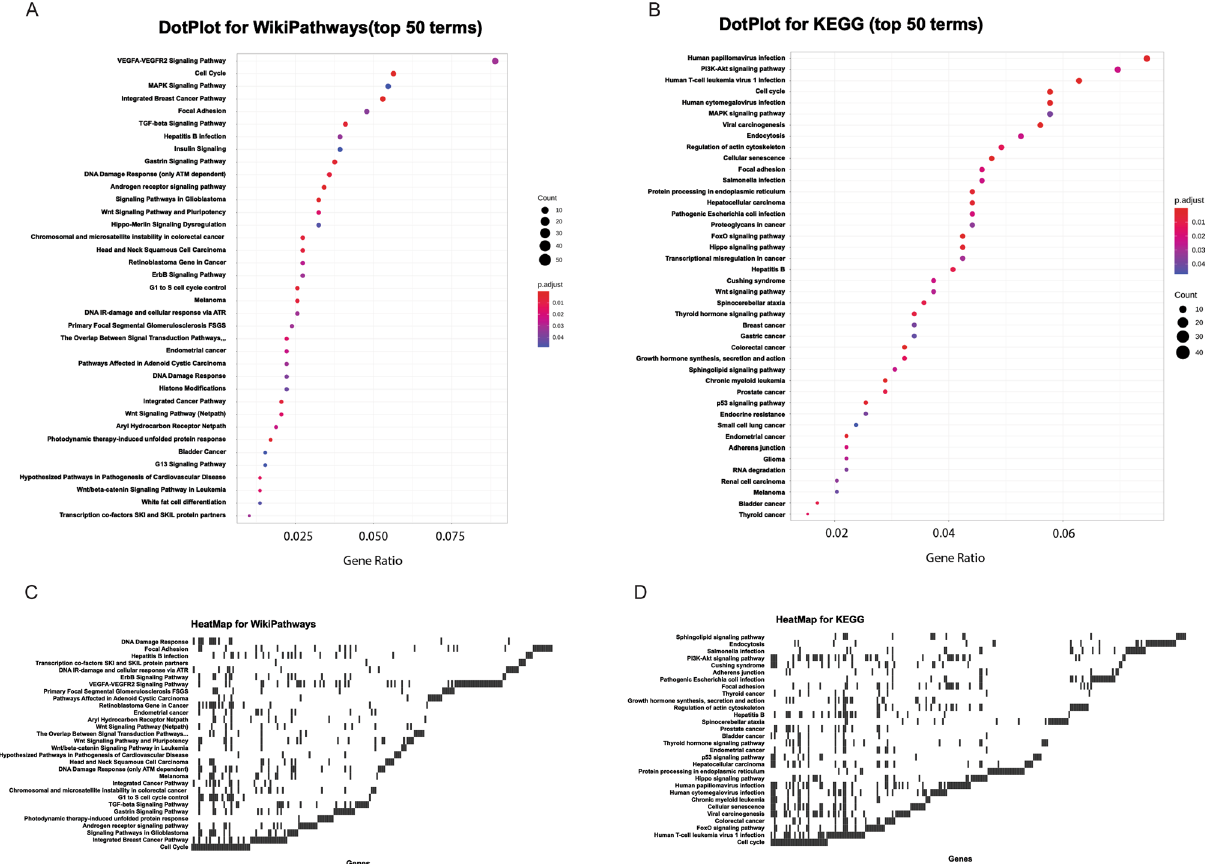
Figure 6. WikiPathway 49 ( A , C ) and KEGG 15 ( B , D ) enrichment analyses for H. sapiens genes, putatively targeted by M. oleifera